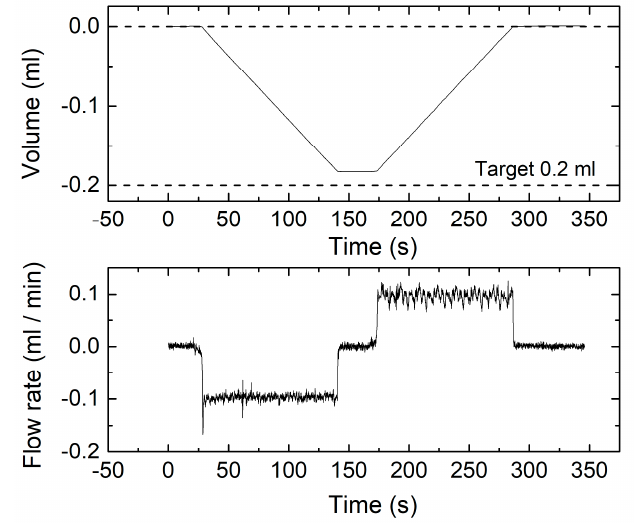
Figure 13. Instantaneous measured volume ( top ) and flow rate ( bottom ) for a measurement cycle obtained by programming the syringe pump for a 0.2 mL volume and 0.1 mL/min flow rate.